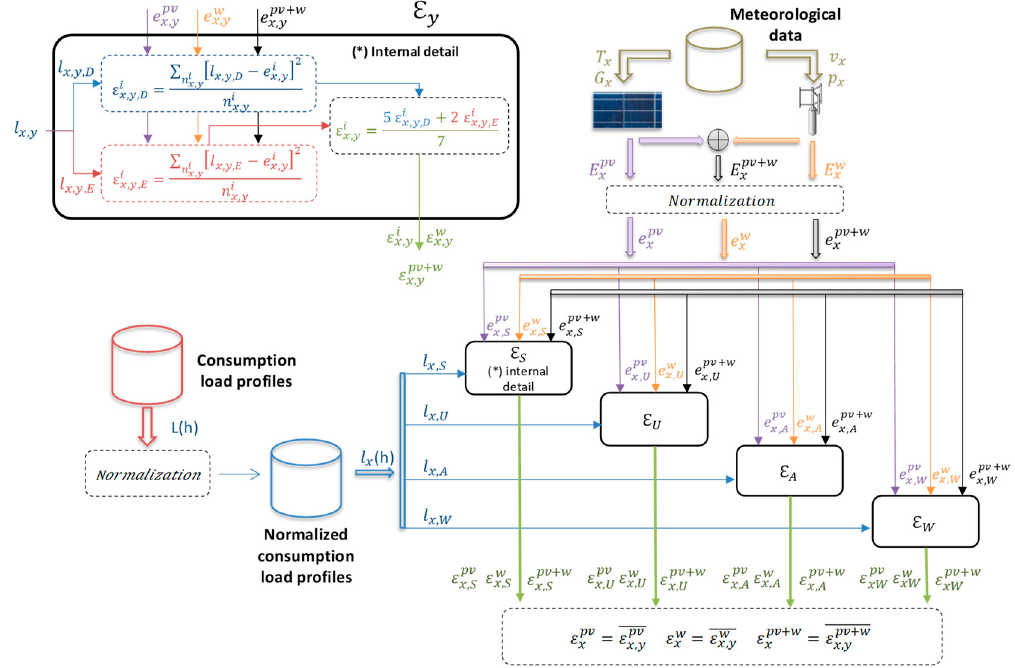
Figure 2. Methodology for obtaining the matching factor ( ε ) at a single location.